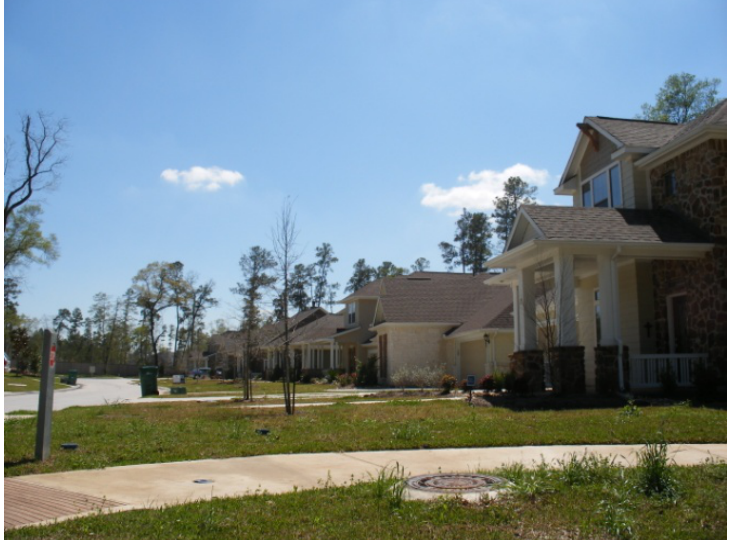
Figure 5. Typical neighborhood views in comparative Houston communities in the Bear Creek watershed (less consideration of preserving vegetation and curb-and-gutter conventional